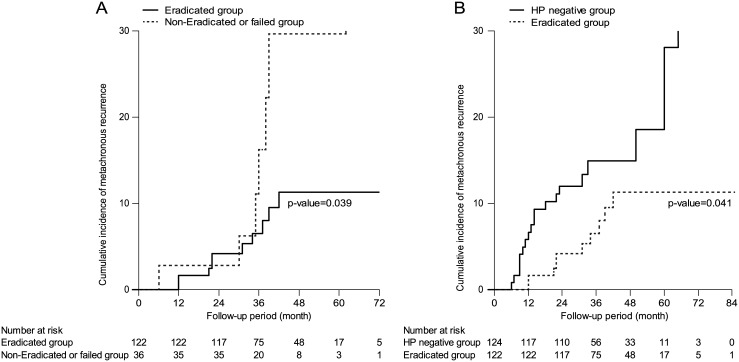
(A) The cumulative incidence of metachronous recurrence was significantly lower in the H. pylori-eradicated group in comparison with the H. pylori-persistent (non-eradicated or failed) groups (p = 0.039). (B) The cumulative incidence of metachronous recurrence was significantly lower in the H. pylori-eradicated group in comparison with the H. pylori negative group (p = 0.041).